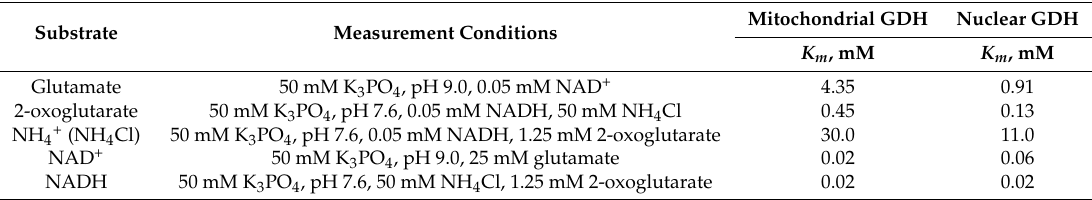
Table 2. Michaelis constants for substrates ( K m ) determined for the mitochondrial and nuclear GDH from rat liver